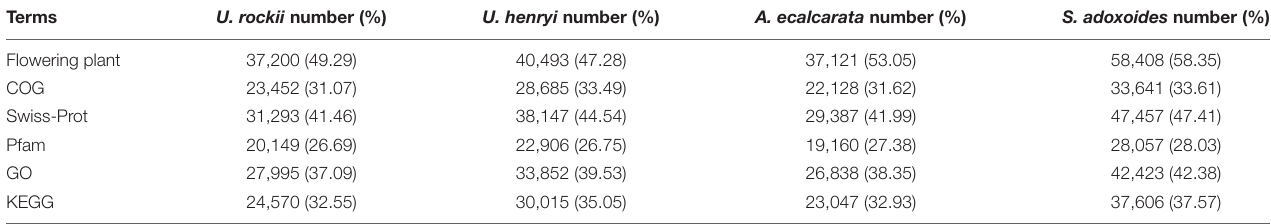
TABLE 2 | Statistics of annotations for